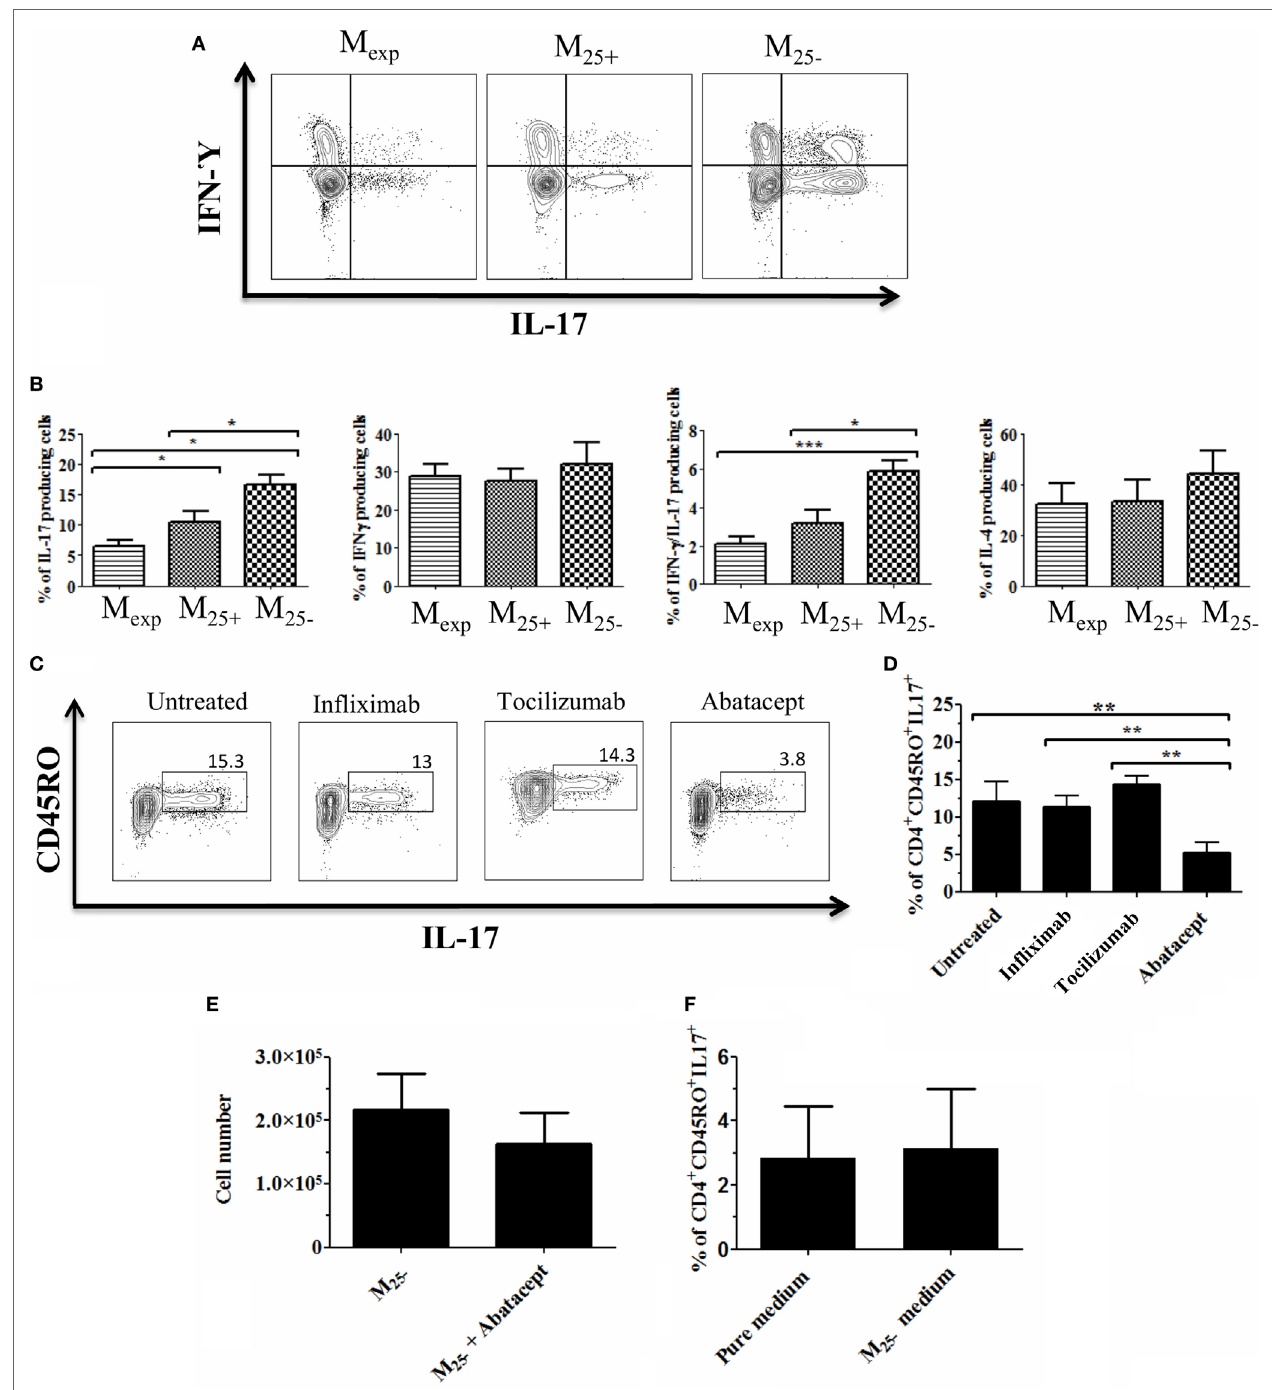
FigUre 5 | M exp reduced the generation of IL-17-producing cells due to their lower CD86 expression. (a) Representative plots showing the percentages of IL-17, IL-17/IFN- γ , and IFN- γ -producing CD4 + cells after co-culture with M exp , M 25 + , and M 25 − . (B) Cumulative data of nine independent experiments showing the percentages of IL-17, IL-17/IFN- γ , and IFN- γ and IL-4 producing CD4 + cells. Representative plots (c) and cumulative data (D) of four independent experiments showing the percentages of memory IL-17-producing CD4 + cells after co-culture with M 25 − alone or in the presence of infliximab, tociluzmab, and abatacept. (e) Cell count of CD4 + cells ( n = 4) co-cultured with M 25 − alone or in the presence of Abatacept. (F) Cumulative data of four independent experiments showing the percentages of memory IL-17-producing CD4 + stimulated with anti-CD3/28 beads in medium alone or M 25 − conditioned medium. In all the experiments, data, presented as mean ± SEM, were analyzed using one-way ANOVA followed by Tukey with * p < 0.05, ** p < 0.01.